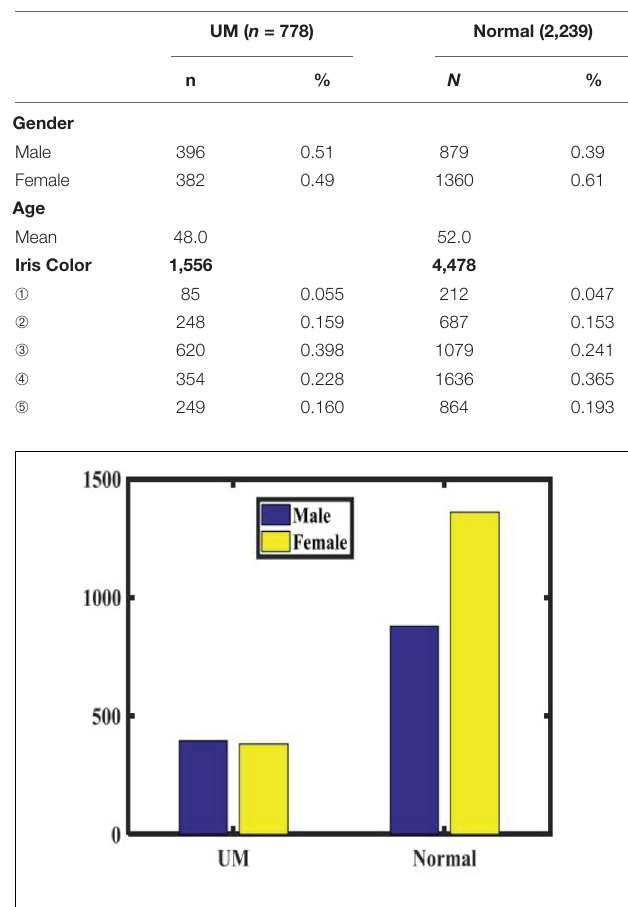
FIGURE 1 | Sex ratio of patients in the two